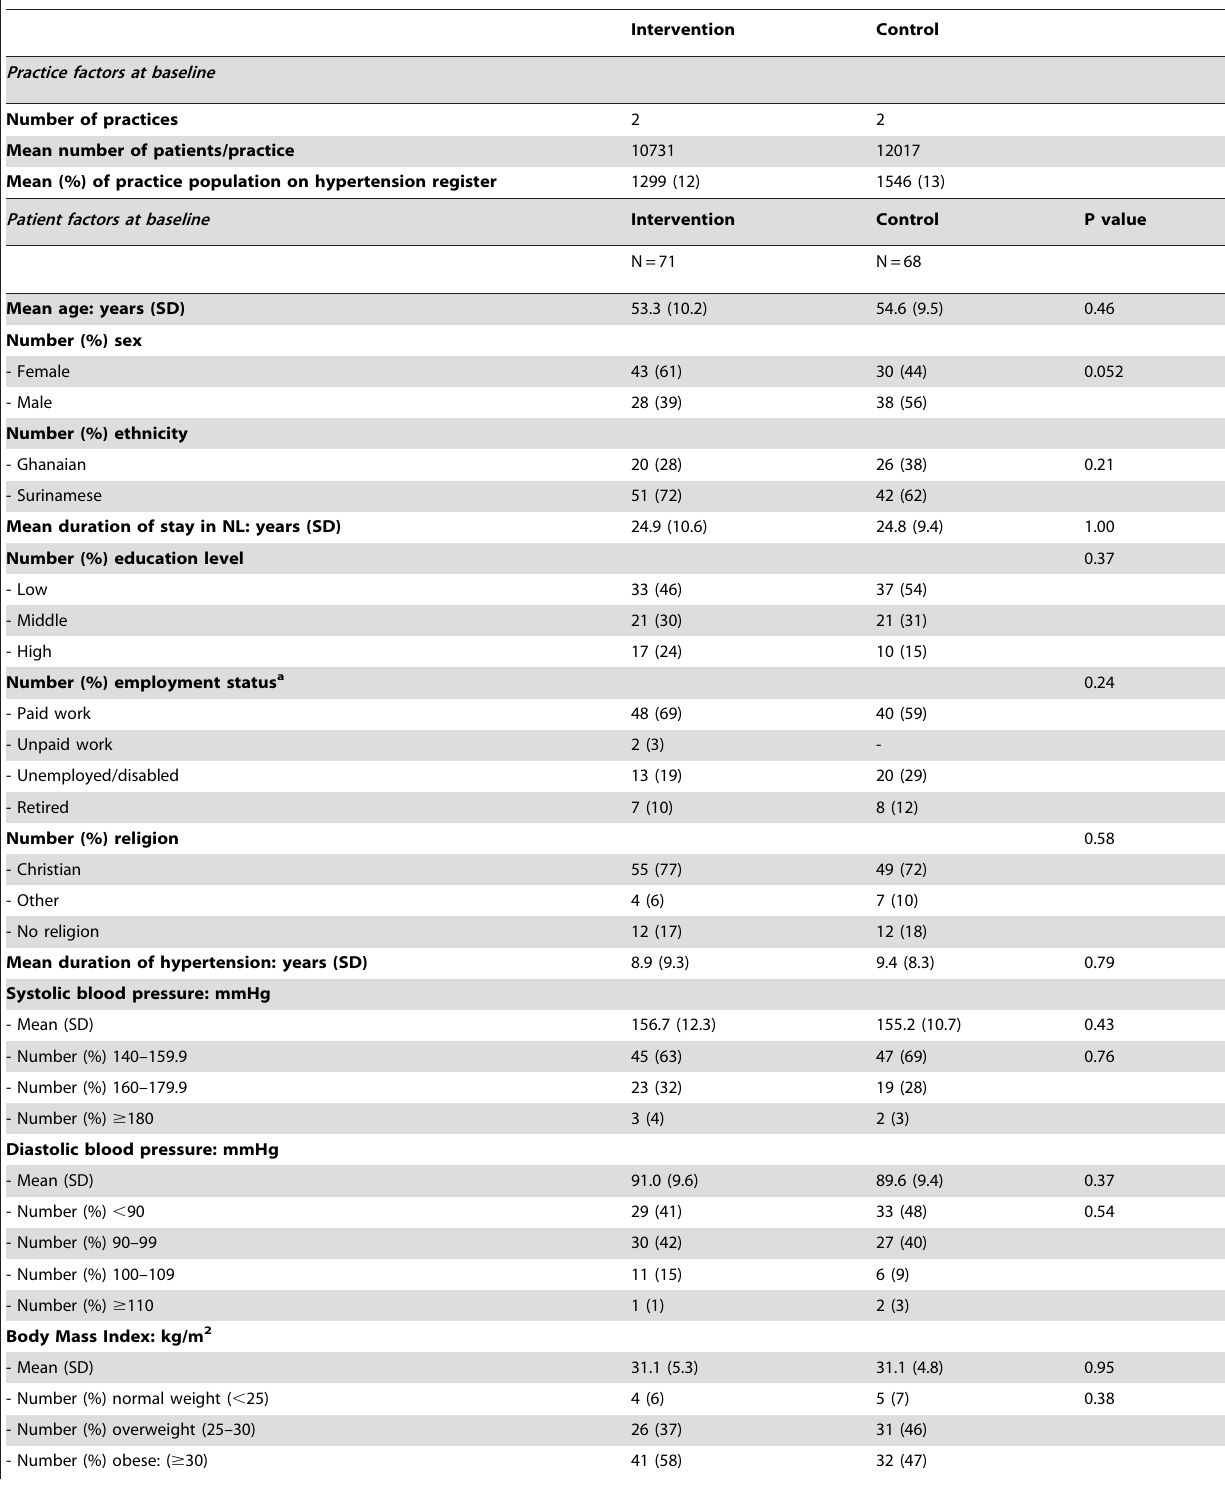
Table 3. Baseline characteristics of study practices and patients, according to treatment condition